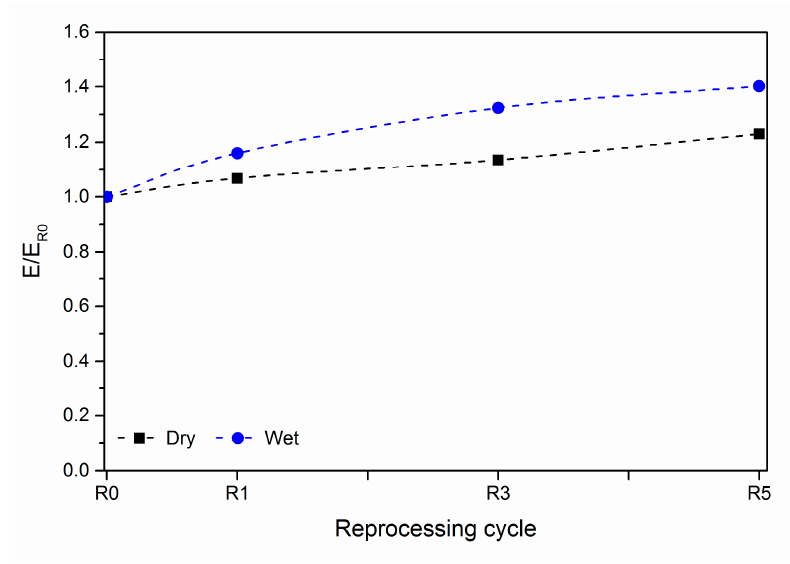
Figure 5. Dimensionless elastic modulus as a function of the reprocessing cycles.